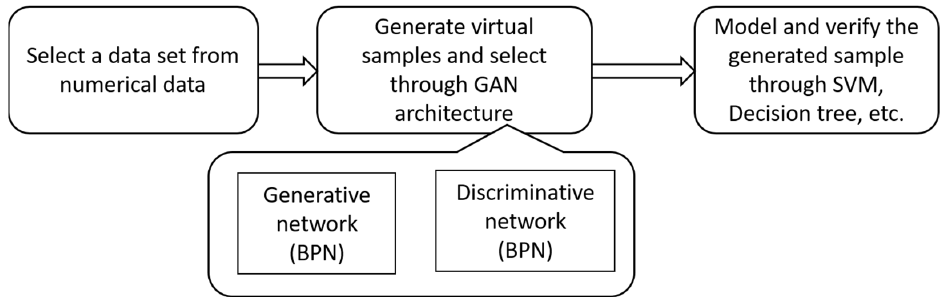
Figure 5. The procedure of the proposed